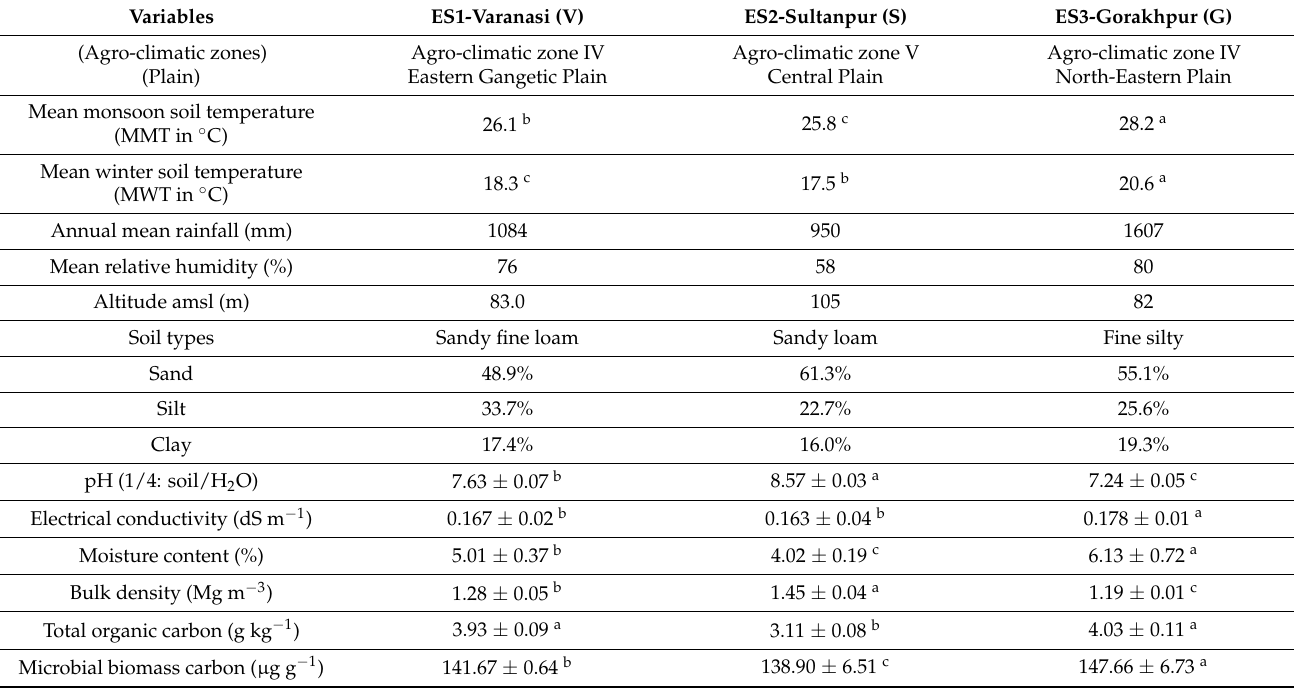
Table 1. Agrometeorological and soil quality of the study areas. For soil-quality values, means with different letters ( a–c ) within a row indicate significant difference at p ≤ 0.05.